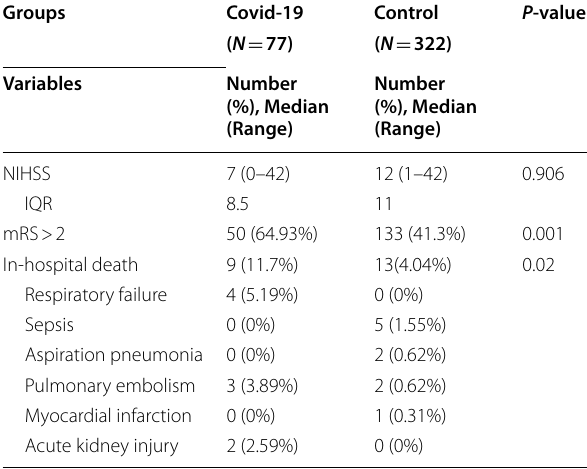
MRS The modified Rankin Scale, NIHSs National Institutes of Health Stroke Scale